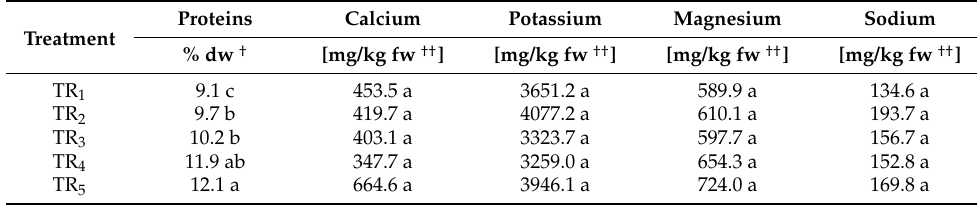
Table 11. Qualitative parameters wheat grain